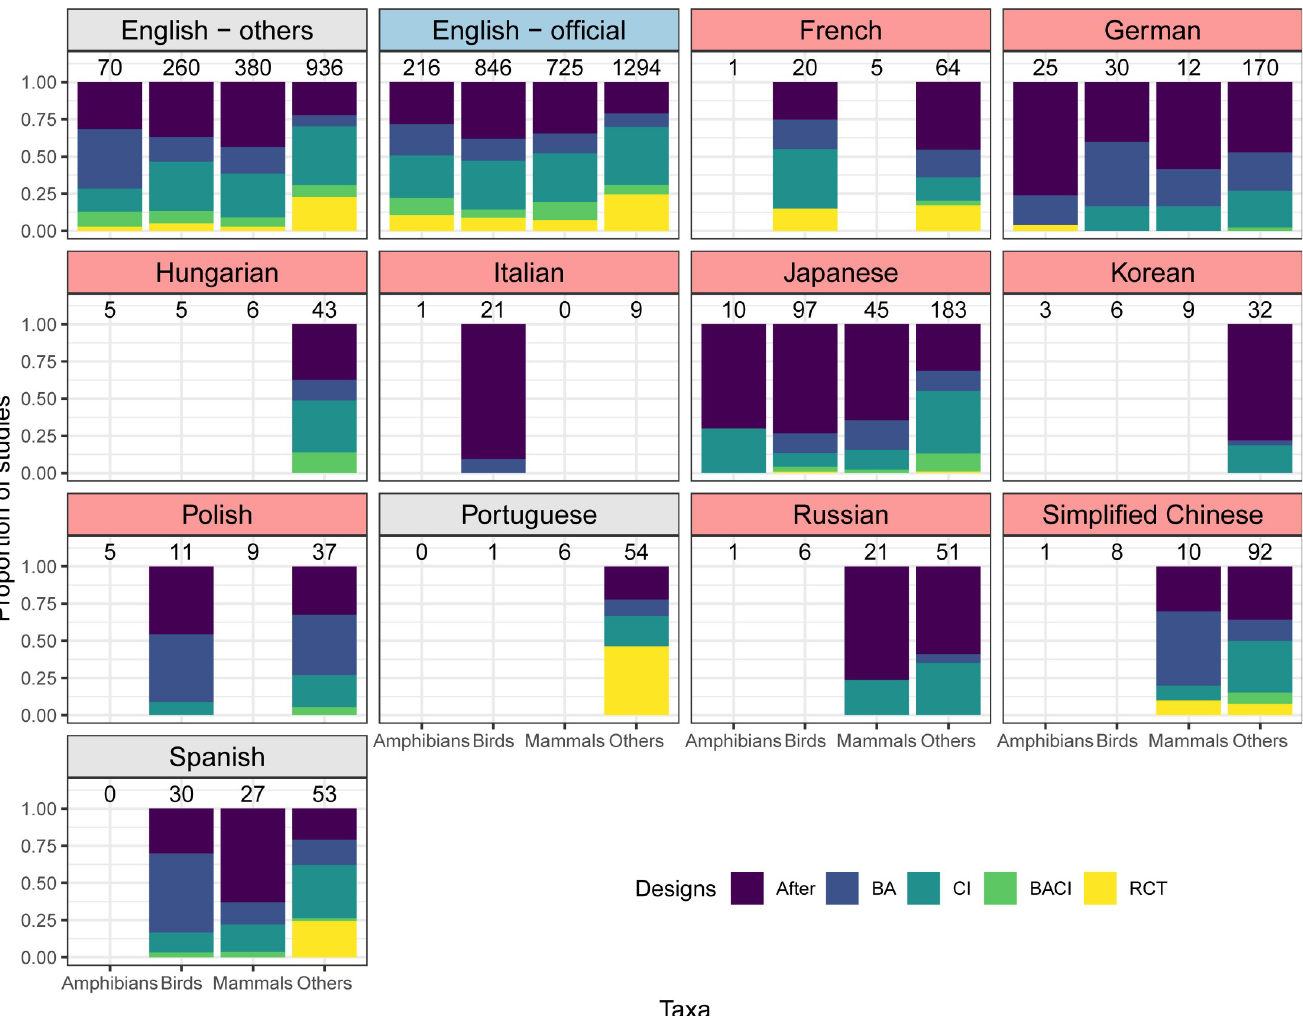
Fig 2. The proportion of studies in different languages that tested the effectiveness of conservation interventions with different study designs. Designs in the order of increasing robustness: After, BA, CI, BACI, or RCT. “English–others”: English-language studies conducted in countries where English is not an official language. “English–official”: English-language studies conducted in countries where English is an official language. Languages with statistically less robust designs compared to “English–others” are shown with pink background, those with statistically more robust designs with blue background, and those with a nonsignificant difference with grey background. The numbers above bars represent the number of studies in each taxon (i.e., amphibians, birds, mammals or others)—language group. Only groups with at least 10 studies are shown. Studies in 5 languages (Arabic, Persian, traditional Chinese, Turkish, and Ukrainian) are not shown as no taxon—language group had 10 or more studies; see S3 Data for study designs adopted in those languages. This figure was created using S3 and S4 Data with Code 2. BA AU : AnabbreviationlisthasbeencompiledforthoseusedinFig 2 : Pleaseverifythatallentriesarecorrect : , Before–After; BACI, Before–After–Control–Impact; CI, Control–Impact; RCT, Randomised Controlled Trial.